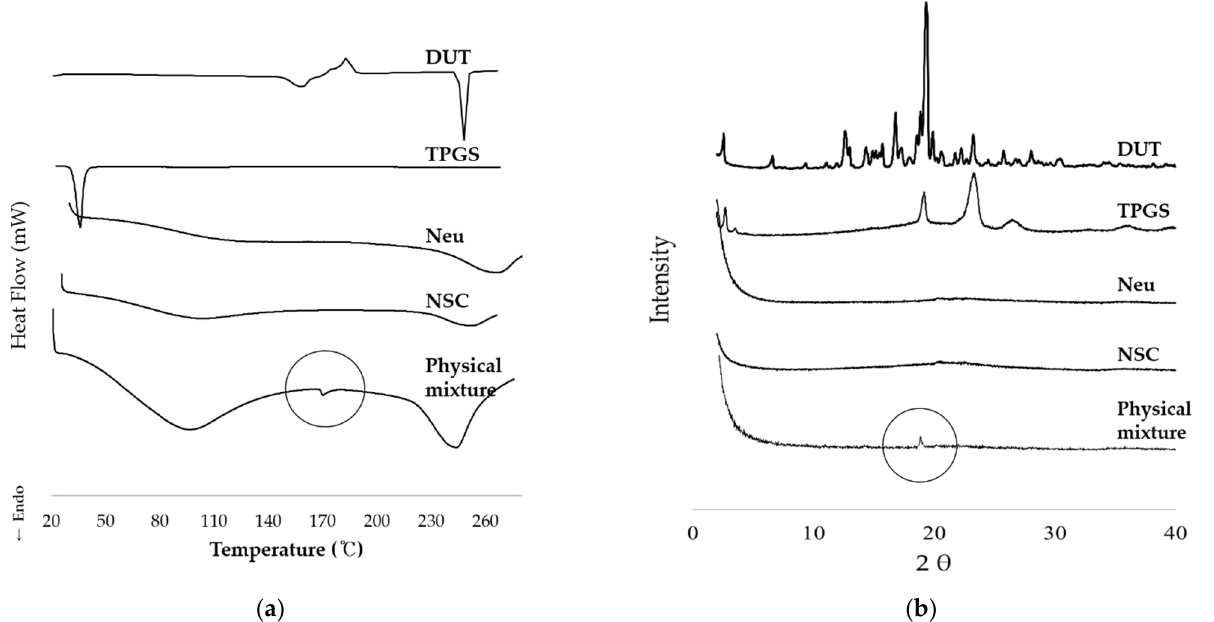
Figure 3. Physicochemical characterization of the interaction between DUT and nanoporous silica entrapped lipid-drug complex. ( a ) DSC analysis; ( b ) HP-XRD analysis. Abbreviations: DUT, dutasteride; DSC, Differential scanning calorimetry; HP-XRD, high powder X-ray diffractometer.